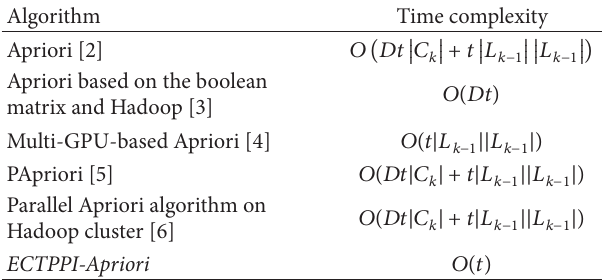
Table 1: Time complexities of some Apriori